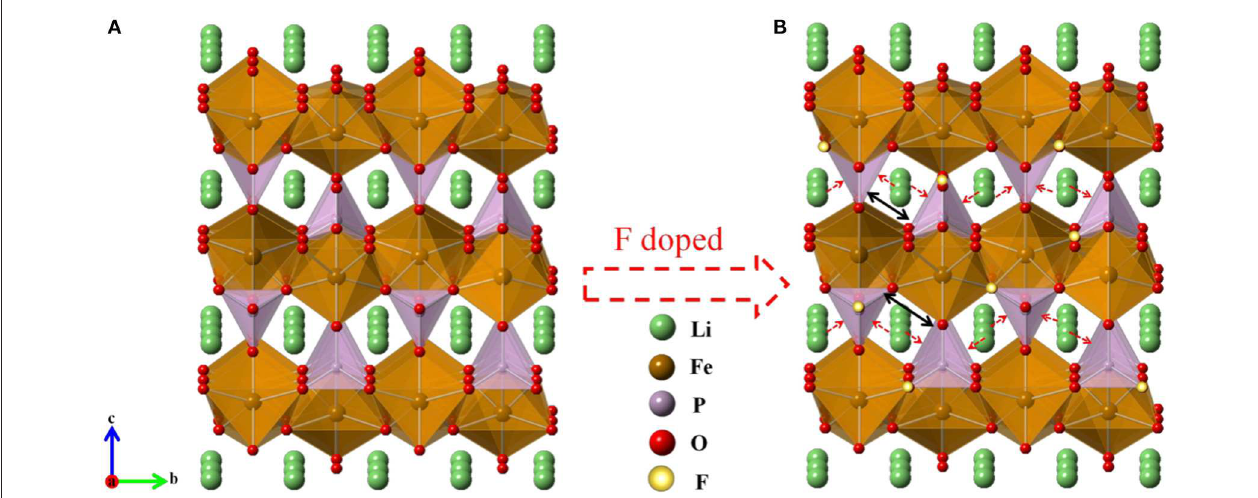
FIGURE 3 | XPS patterns of (A) survey spectrum of LFPF/CF composites, (B) Fe 2p of LFP, LFP/C, and LFPF/CF composite, (C) C 1s, and (D) F 1s of LFPF/CF composite.